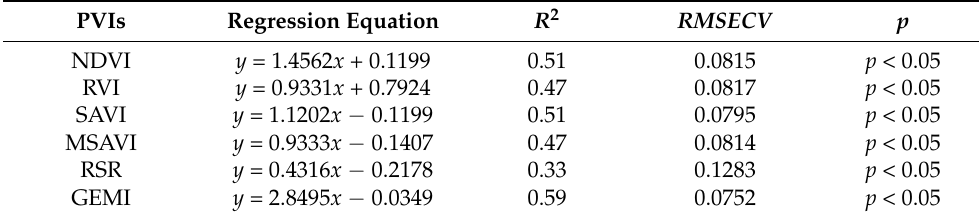
Table 3. Parameters of linear regression analyses between PVIs and f PV